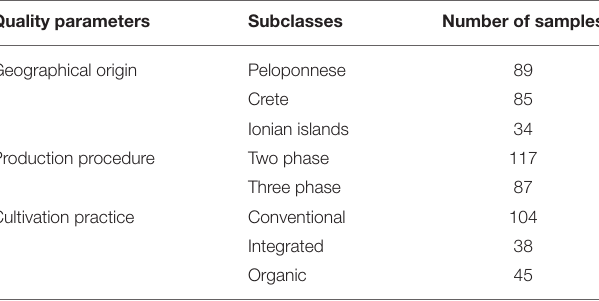
TABLE 1 | Representation of the total number of samples under investigation ( n =